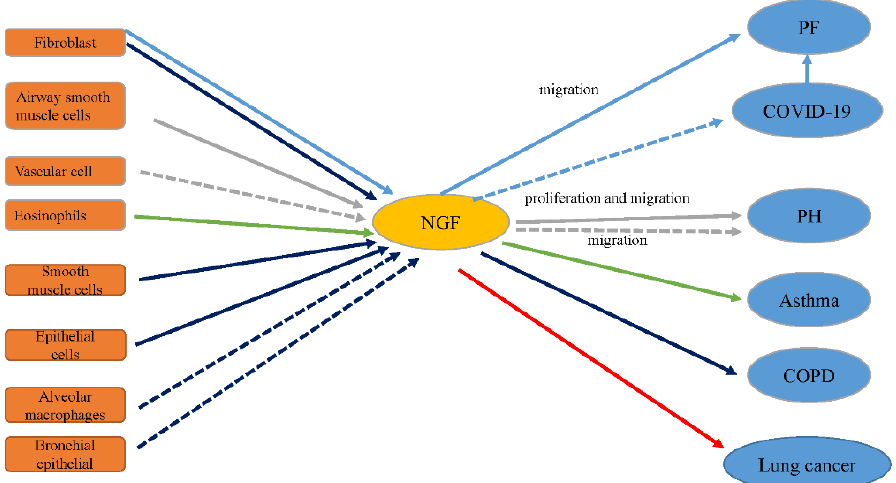
Figure 2. The influence of NGF on lung disease. NGF is expressed in many cells in the lung. Once released, NGF could stimulate diverse types of cells involved in many processes in lung diseases. The relationships between NGF and respective lung diseases are described in the following sections. The blue arrows represent the relationship between NGF and PF; the blue dotted arrow represents a potential effect; the gray arrows represent the relationship between NGF and PH; the green arrows indicate the relationship between NGF and asthma; the purple arrows represent the relationship between NGF and COPD; and the red arrows represent the relationship between NGF and lung cancer.